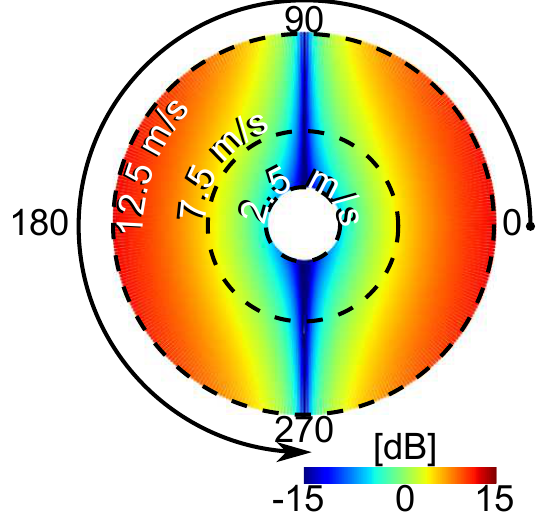
Figure 2: Estimated damping factor plotted against the relative angle between radar and wind direction. Radial distance from the center indicates the wind